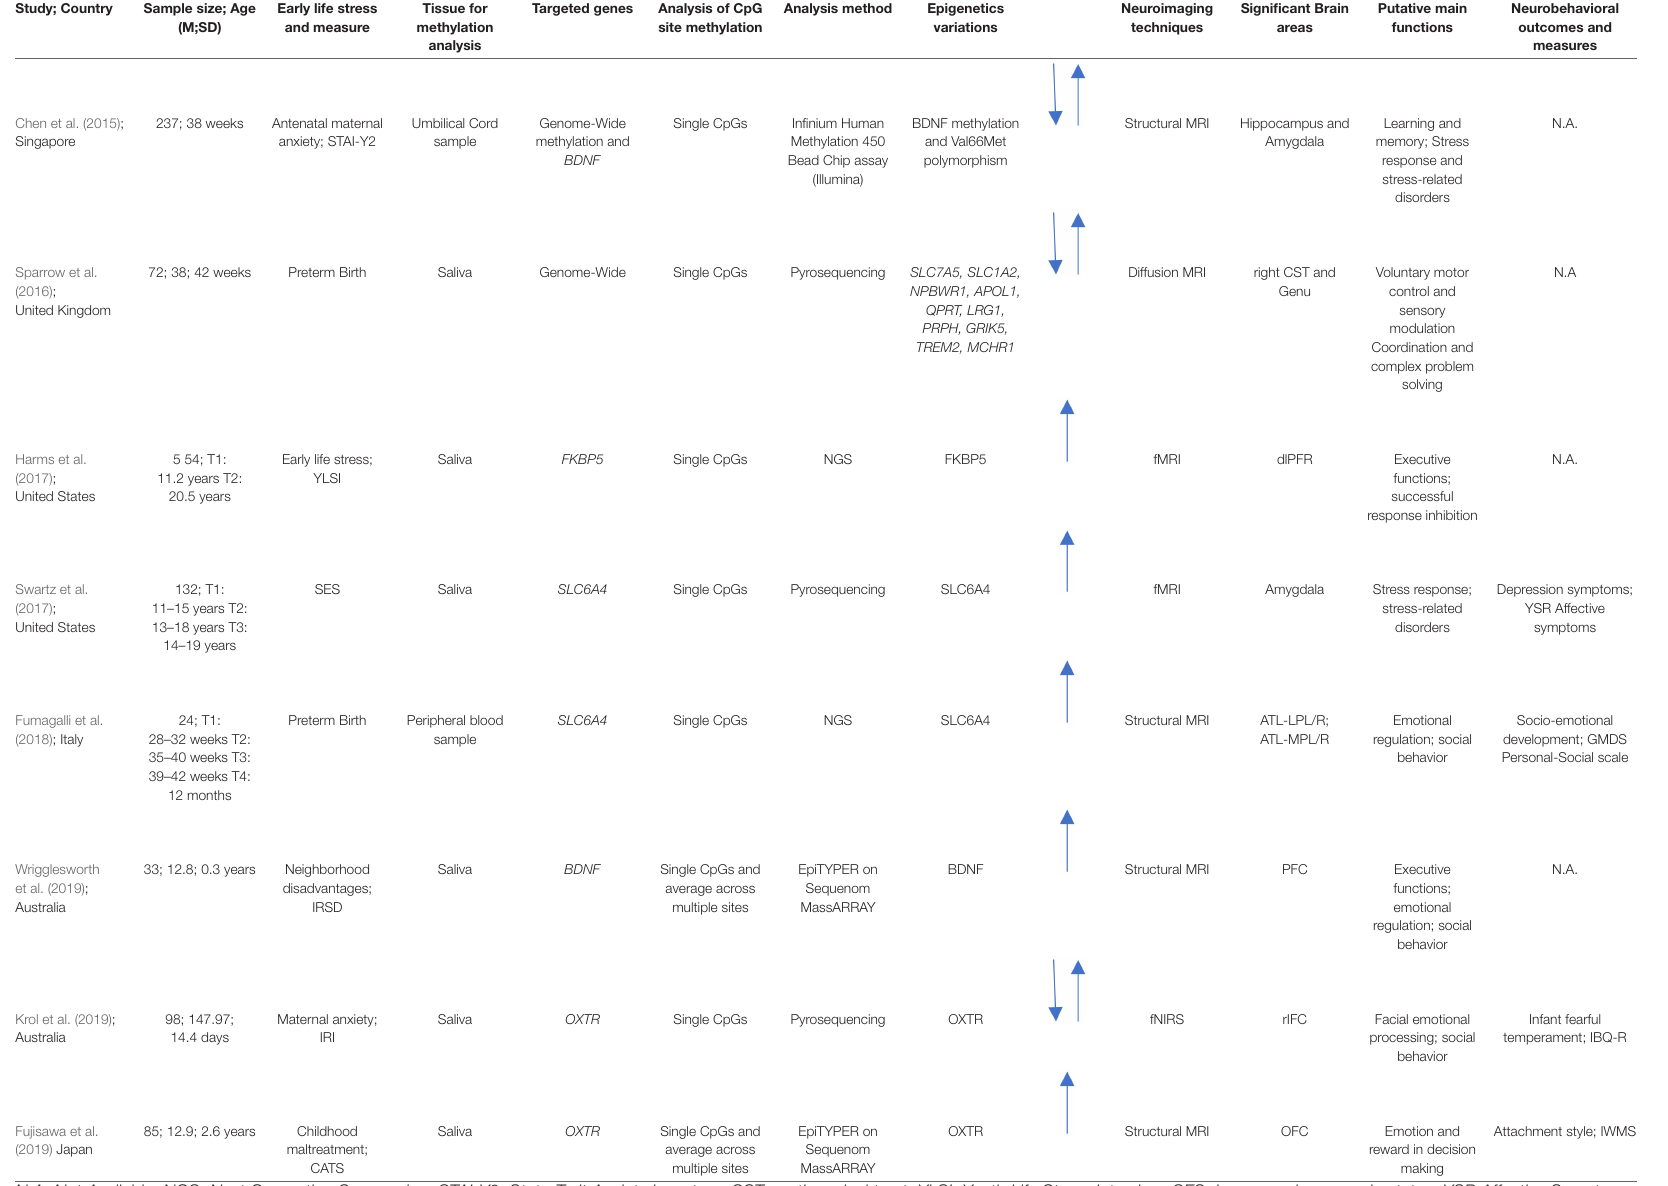
TABLE 2 | Summary of sample characteristics, epigenetic analyses, neuroimaging techniques, and neurobehavioral data. Study;